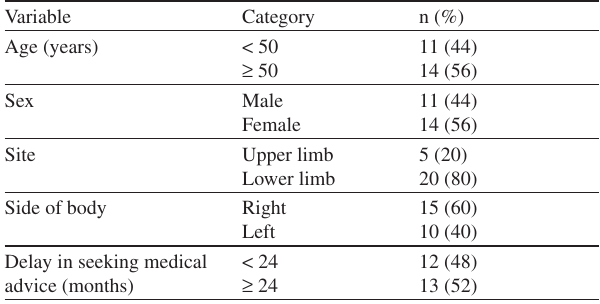
Table 1 - Distribution of clinical and epidemiological vari- ables for the 25 patients with primary liposarcoma of the extremities